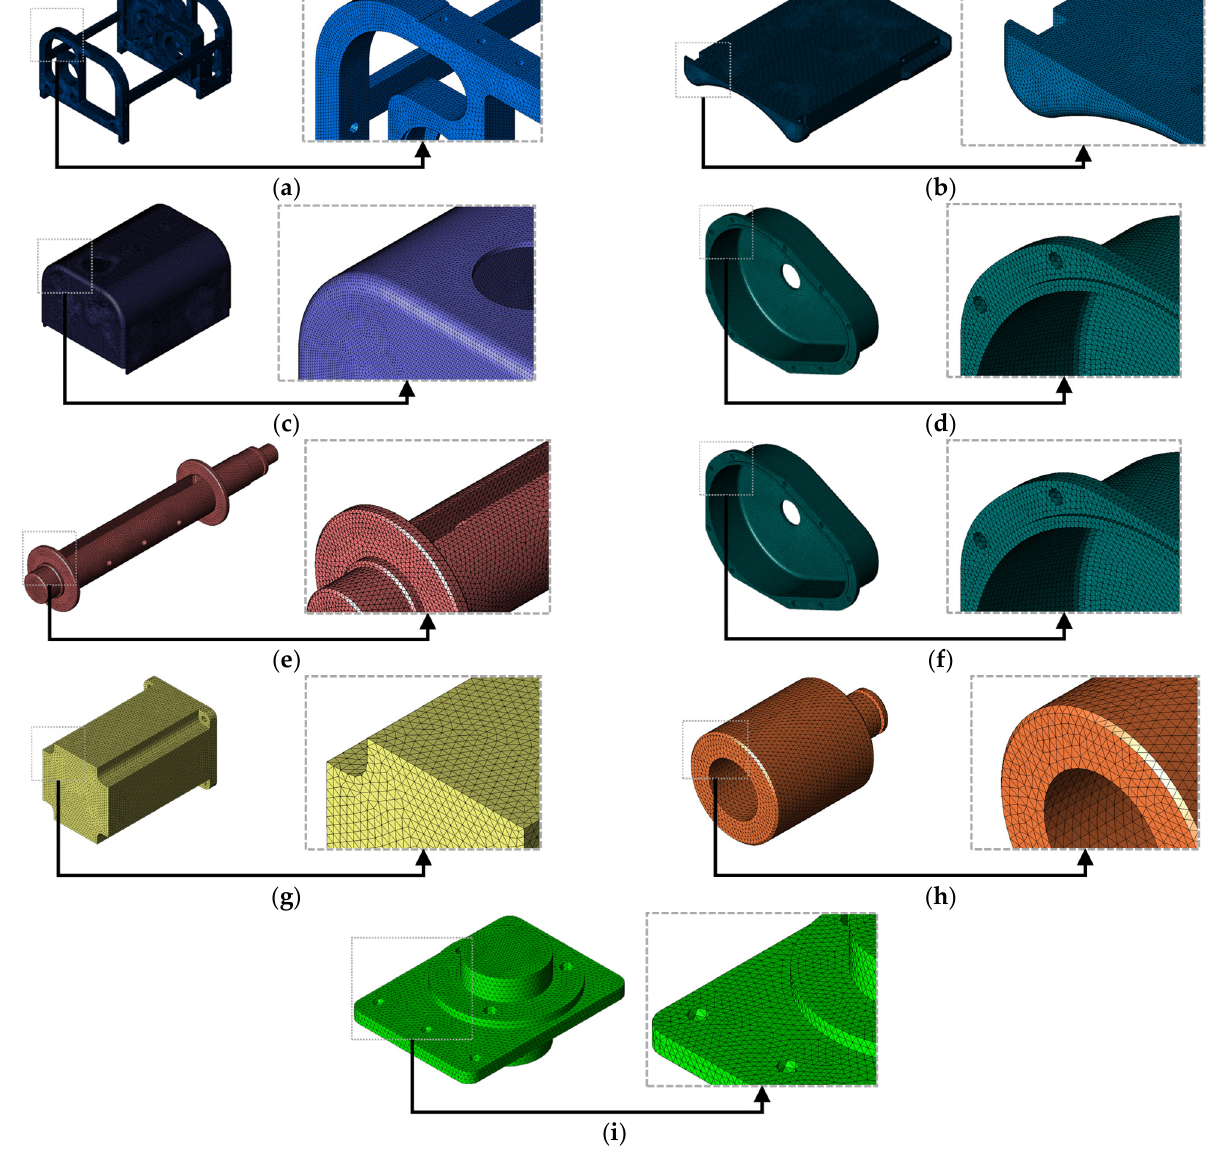
Figure 10. Mesh shape: ( a ) Frame; ( b ) Main cover; ( c ) Top cover; ( d ) Gear cover; ( e ) Main shaft; ( f ) Idle shaft; ( g ) Motor; ( h ) Motor shaft connector; ( i ) Connector.